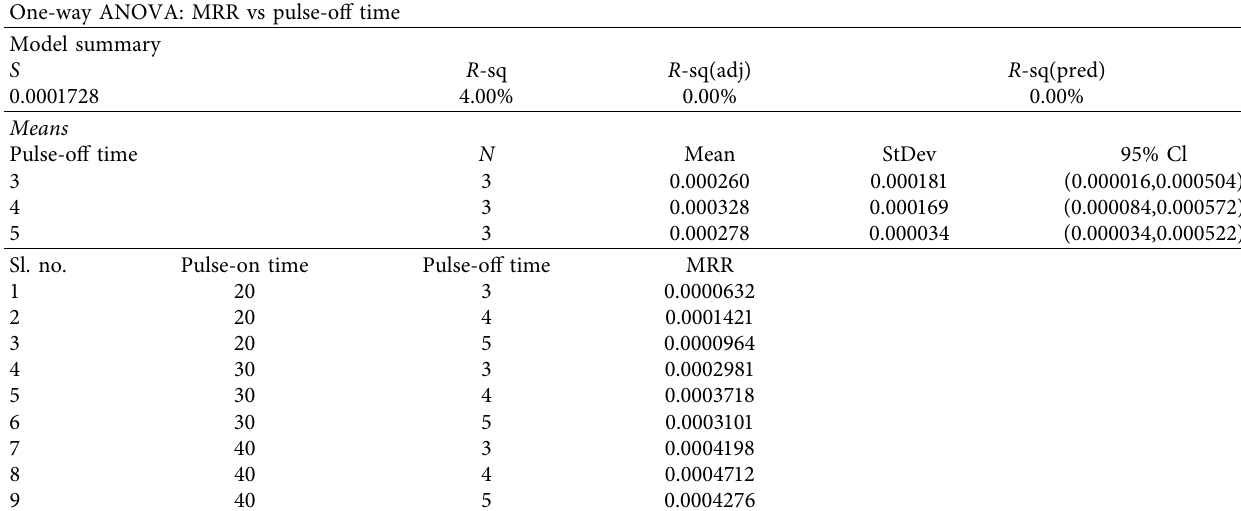
Table 3: A typical Minitab software was used for experiment analysis.